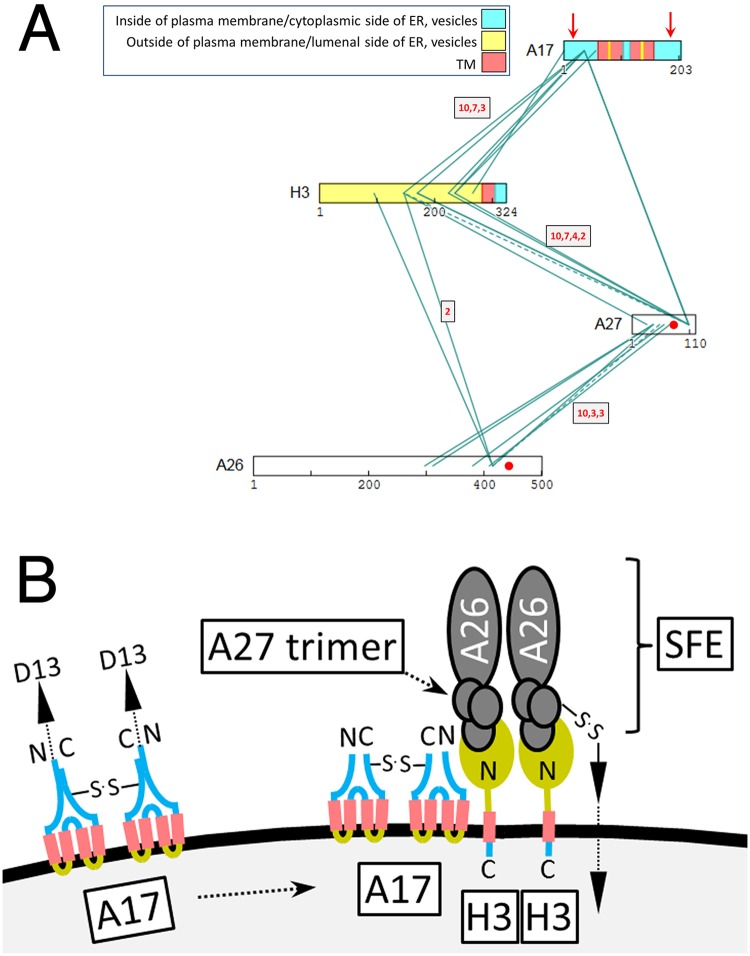
(a) Crosslinkome for major membrane proteins A17, H3, A27, A26. Yellow, red and cyan fill: ‘Outside’, TM and ‘inside’ domains, respectively, with “Inside” and “Outside” following the convention of the program TMHMM [68] in which “inside” refers to the cytoplasmic side of plasma membrane, ER membrane or vesicles for a classically embedded TM protein, and “outside” refers to the lumenal side or the ER or external side of the plasma membrane. Vertical red arrows: AG|-specific processing sites in protein A17. Red spots (A26, A27): Cysteines that are disulfide bonded to one another. Other details as in Fig 5. (b) Arrangement, at the MV envelope, of proteins shown in panel A satisfying XL, functional and imaging data. Left side: Disulfide bonded homodimers of unprocessed A17 in the IV envelope in reticulon conformation. The unprocessed A17 N-terminus is within crosslinking range of A17’s C-terminal region. The D13 external scaffold is not depicted. Right side: Maturation of the envelope includes A17 N- and C-terminal cleavage and D13 loss. H3 is now non-canonically tail-anchored in the MV envelope with immunodominant N-terminal domain exposed, and SFEs have been added as stacked trimers of A27 and associated A26. H3’s external N-terminal domain mediates most of the interaction between A27 and the processed A17 N-terminal region, with the A17 C-terminus now out of range of H3. The H3/A26 and A27/A17 protein pairs are sufficiently proximal within the A17, H3, A27, A27 network to allow some modest direct crosslinking across their interfaces. SFEs are anchored either directly or indirectly to the core wall beneath the MV envelope by disulfide bonding (arrowed). Proteins CAHH and ATI (not depicted) are candidates for mediating such disulfides. Disulfide bonding does not involve H3 which is detergent-extractable in the absence of disulfide reduction. A27 and A26, although disulfide bonded to one another, interact tightly enough that SFEs show stability in the presence of NP40 plus disulfide reducing agent. ‘N’ and ‘C’ denote protein N- and C-termini respectively. TM protein domains are colored according to panel A and S1 Fig. Although H3 was designated ‘N-outside’ by prediction program TMHMM (opposite polarity to A17), rendering the major N-terminal domain yellow, such predictions are presumably invalid for unconventionally added (tail-anchored) TM proteins (see text). Albeit two copies of the H3-A27 trimer-A26 complex are shown to suggest SFE topology, more accurate modeling would require an understanding of protein stoichiometries.